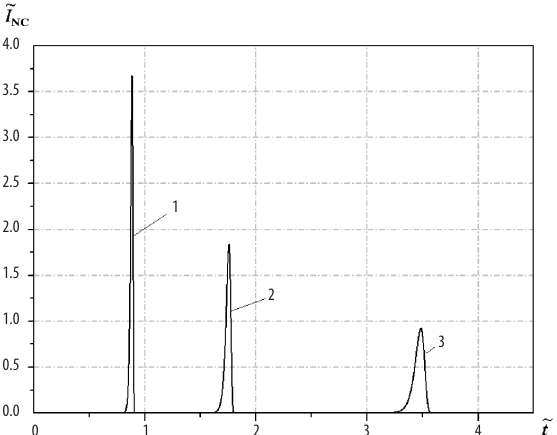
Fig. 2. Dependence of the intensity of acoustic emission Fig. 4. Dependence of change of the effective amplitude of 6 10 − during time on different values of the speed acoustic emission ( ) NC I t   of x 3 10 − during time on different values of speed of the load’s application χ for non-coherent of the load’s application χ for non-coherent addition of waves. summarizing of waves. Values of 0 1/ χτ : 1 –